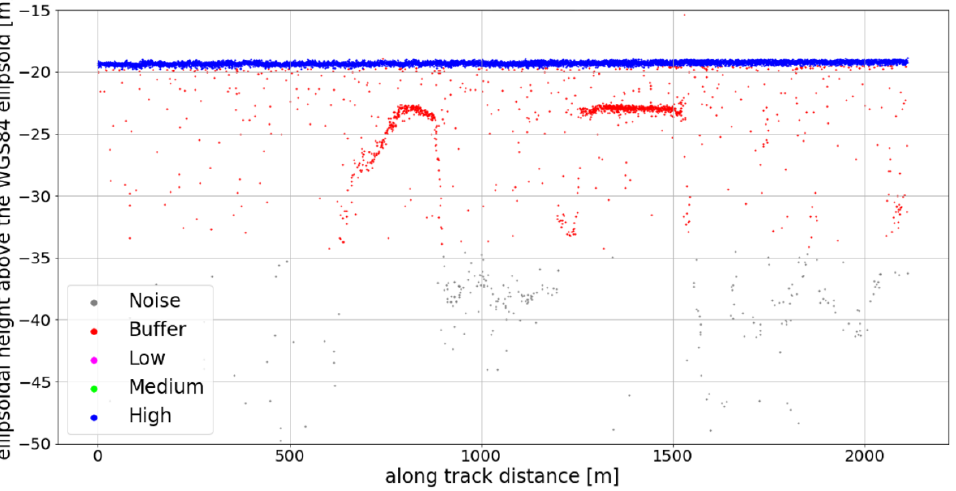
Figure 2. Photon point clouds of the transect along ICESat-2 gt1l (strong beam), acquired on 14 May 2020. The confidence levels provided by ATL03 are displayed.